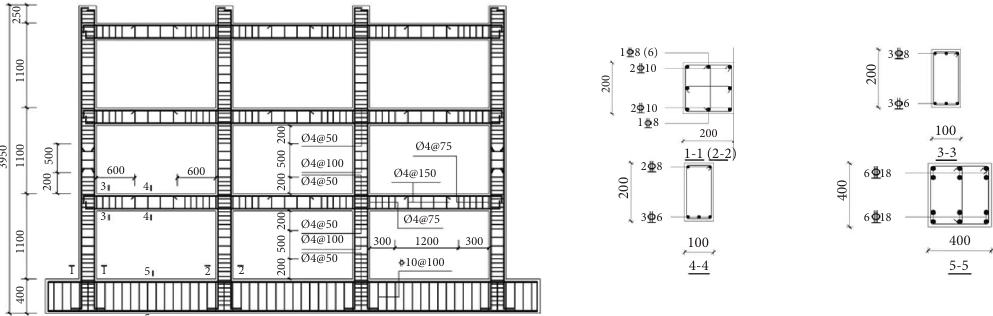
Figure 1: /e size of the